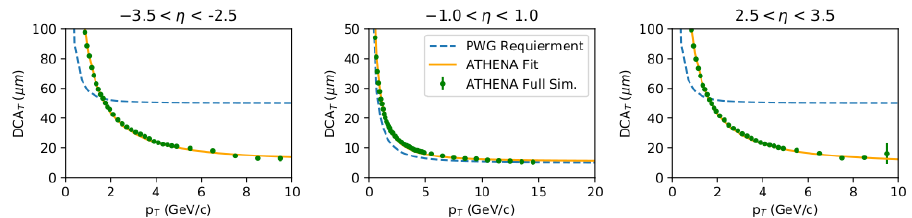
Fig. 4. Transverse DCA resolutions versus transverse momentum for the ATHENA setup corresponding to simulated pions- uniform in η momentum compared to the physics requirements in YR for selected η bins